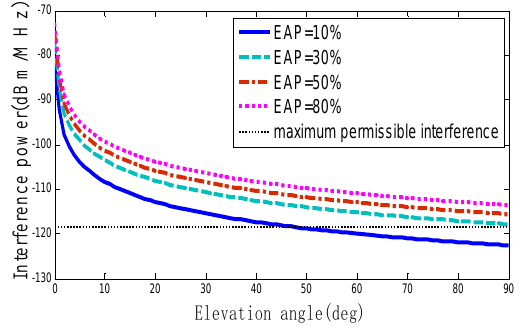
Fig. 5. Interference from IMT BSs to DRS